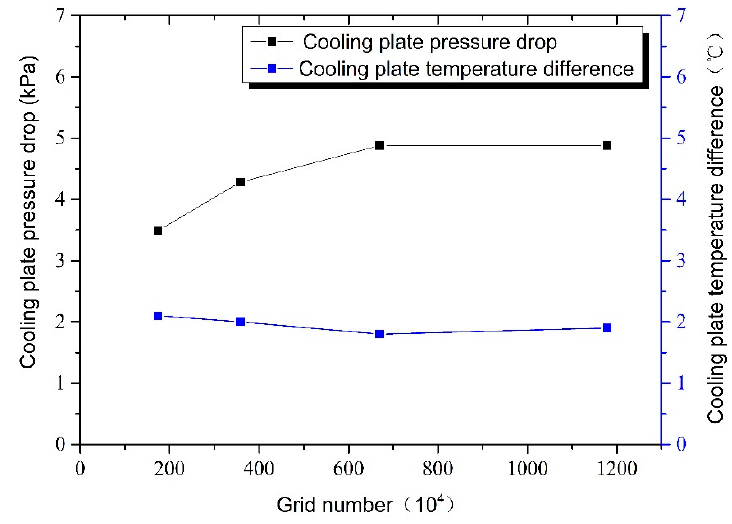
Figure 10. Mesh independence study.